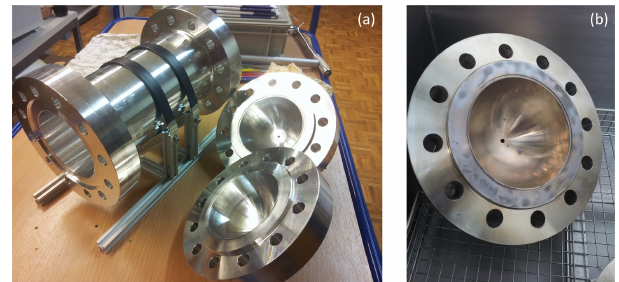
Figure A1. (a) Custom-made cylinder consisting of three pieces. (b) Stains after the ultrasonic bath during the second cleaning pro- cedure (Table